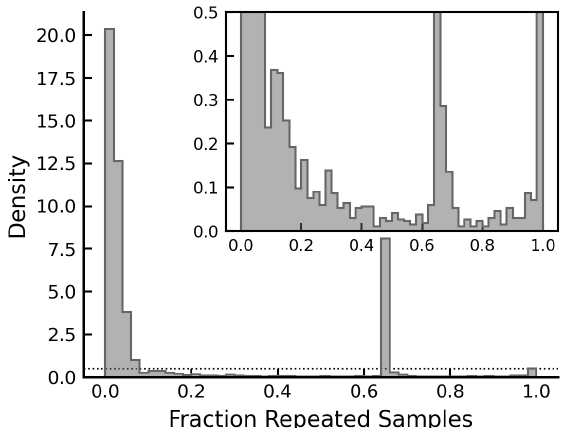
Figure 2. Frequency density histograms of the fraction of repeated samples in each trial (an indirect measure of invalid samples). The inset in the top right corner displays the same histogram with the y axis zoomed to a maximum value of 0.5 (dotted line) to better visualize small frequency densities beyond the three major clusters. Data shown includes all trials regardless of whether the left, right, or combined gaze representation had repeated